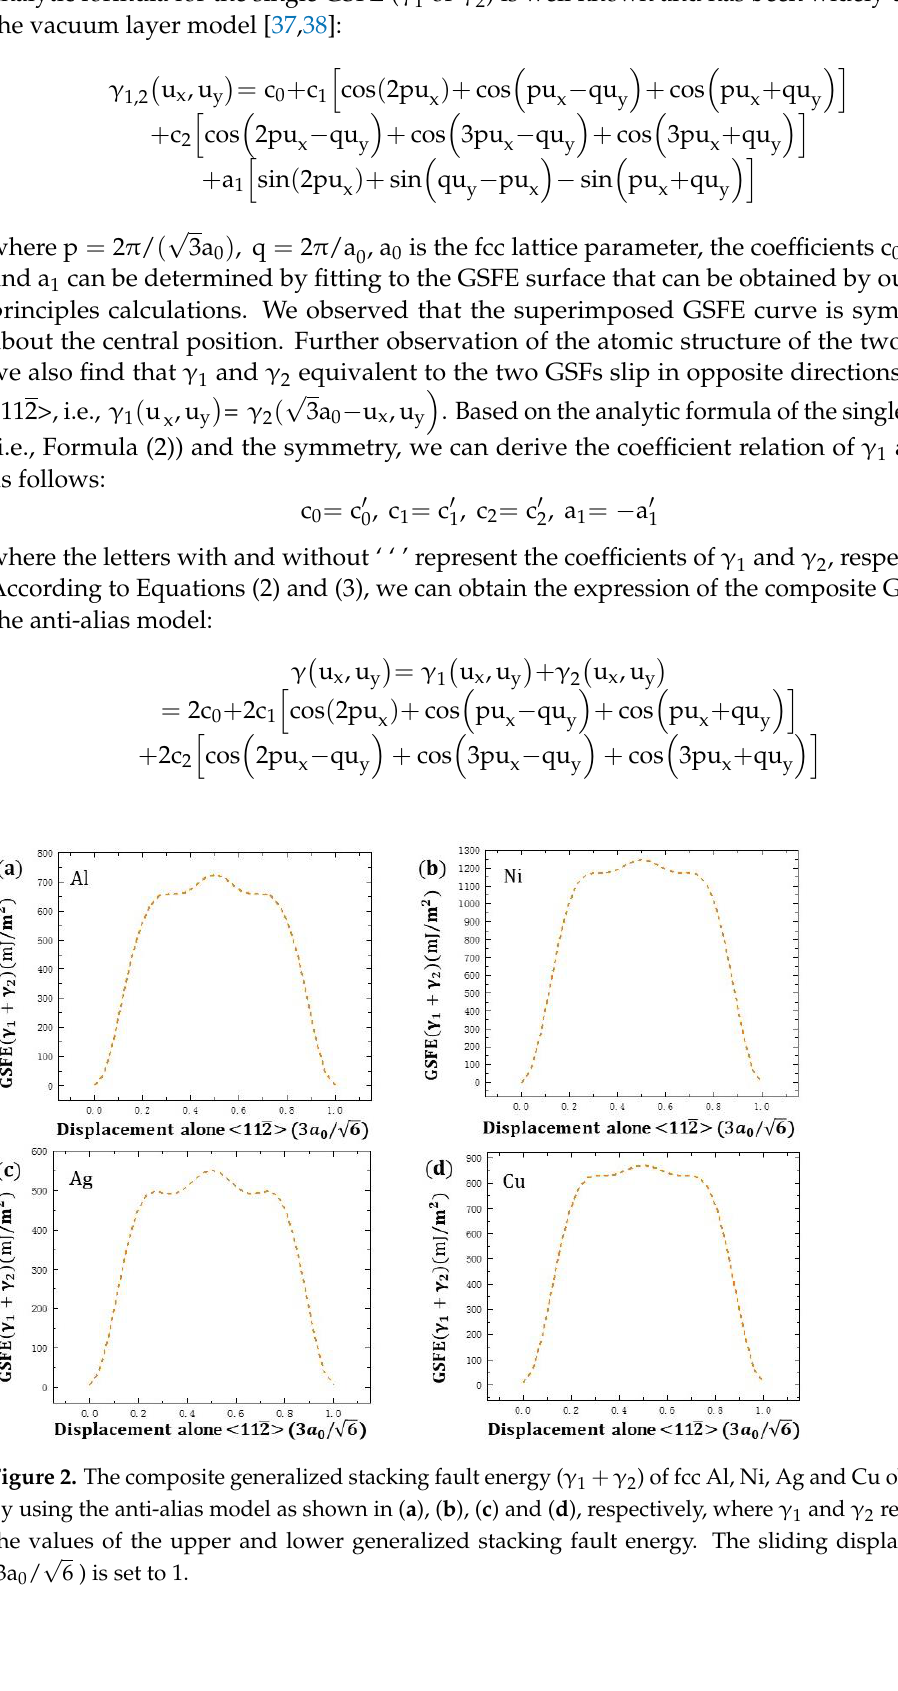
Figure 2. The composite generalized stacking fault energy ( γ 1 + γ 2 ) of fcc Al, Ni, Ag and Cu obtained by using the anti-alias model as shown in ( a ), ( b ), ( c ) and ( d ), respectively, where γ 1 and γ 2 represent the values of the upper and lower generalized stacking fault energy. The sliding displacement (3 𝑎 0 /√6 ) is set to 1.